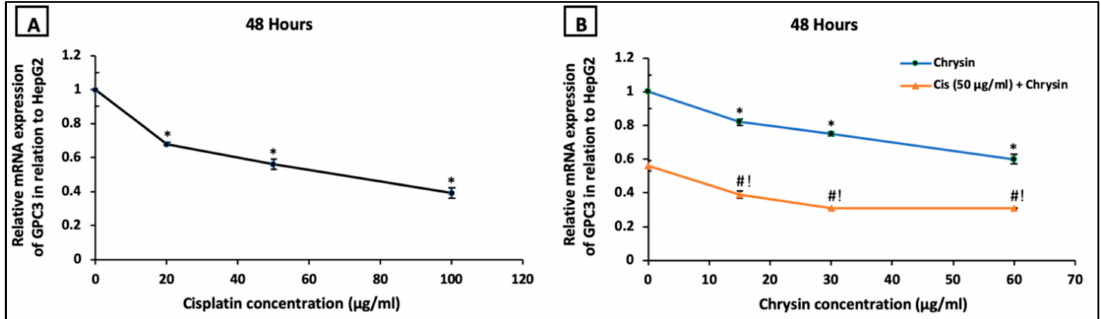
Figure 4. Impact of 48 h treatment with ( A ) cisplatin (Cis; 20, 50, 100 µ g / mL), ( B ) chrysin (15, 30, 60 µ g / mL) and combination of chrysin (15, 30, 60 µ g / mL) with Cis 50 µ g / mL on glypican-3 (GPC3) mRNA expressions in HepG2 cells. Results are presented as Mean ± SD. * p < 0.05 versus the control untreated cells. # p < 0.05 versus the same dose of chrysin. ! p < 0.05 versus Cis 50 µ g / mL.